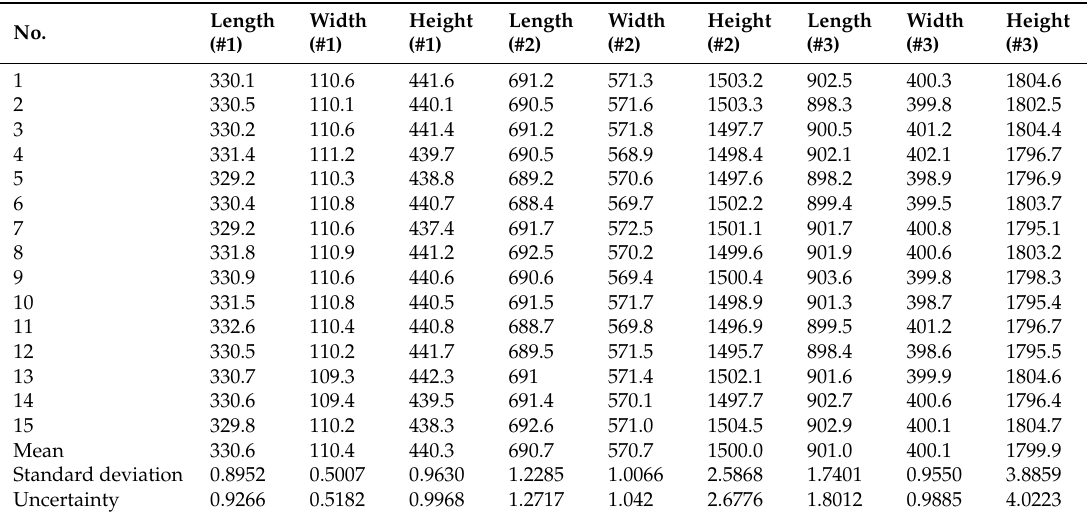
Table 4. Measurement results of the system of three standard boxes (mm).